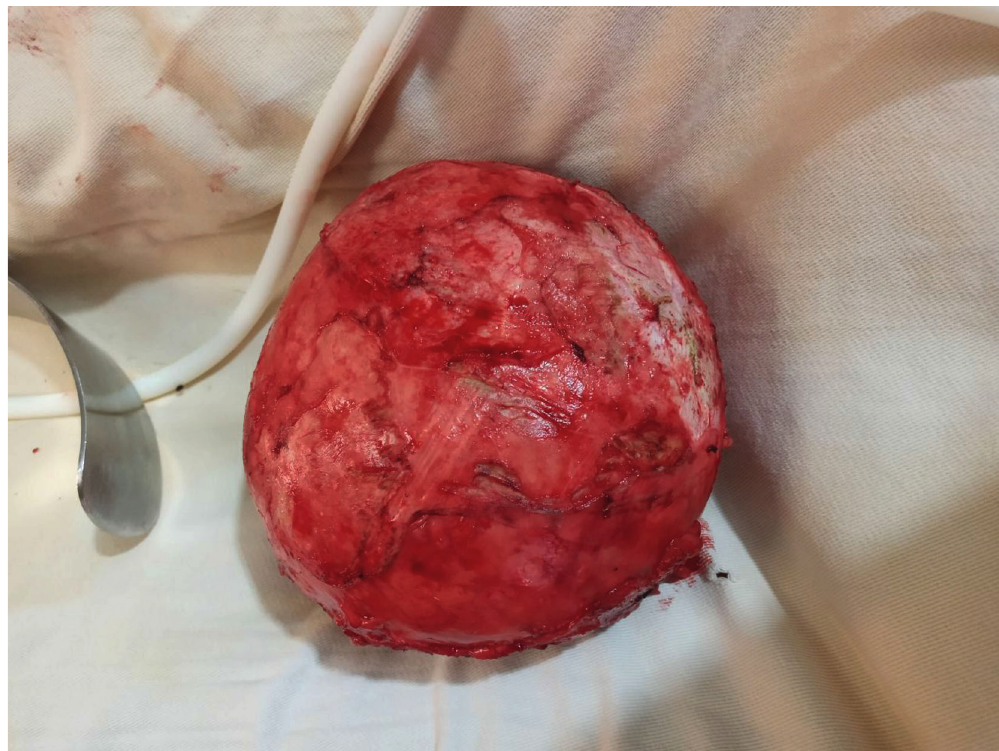
Figure 4: The excised calci fi ed cyst.